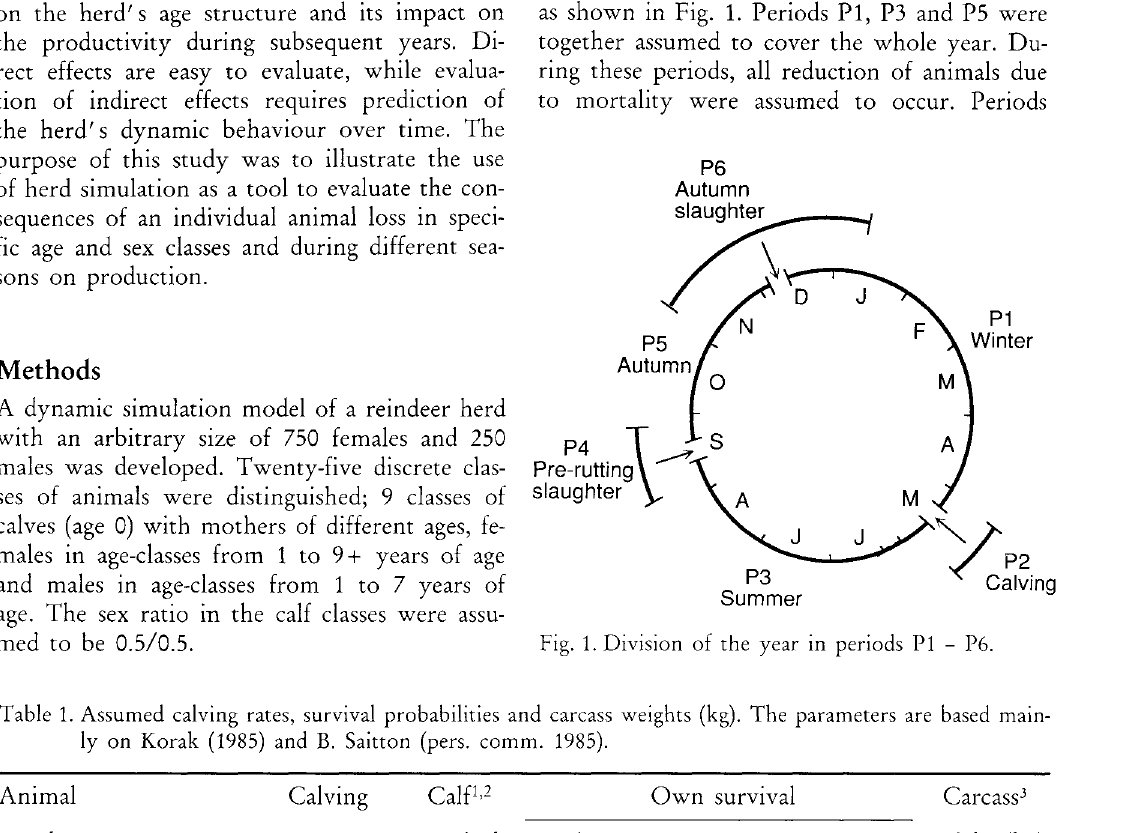
Fig. 1. Division of the year in periods Pl -